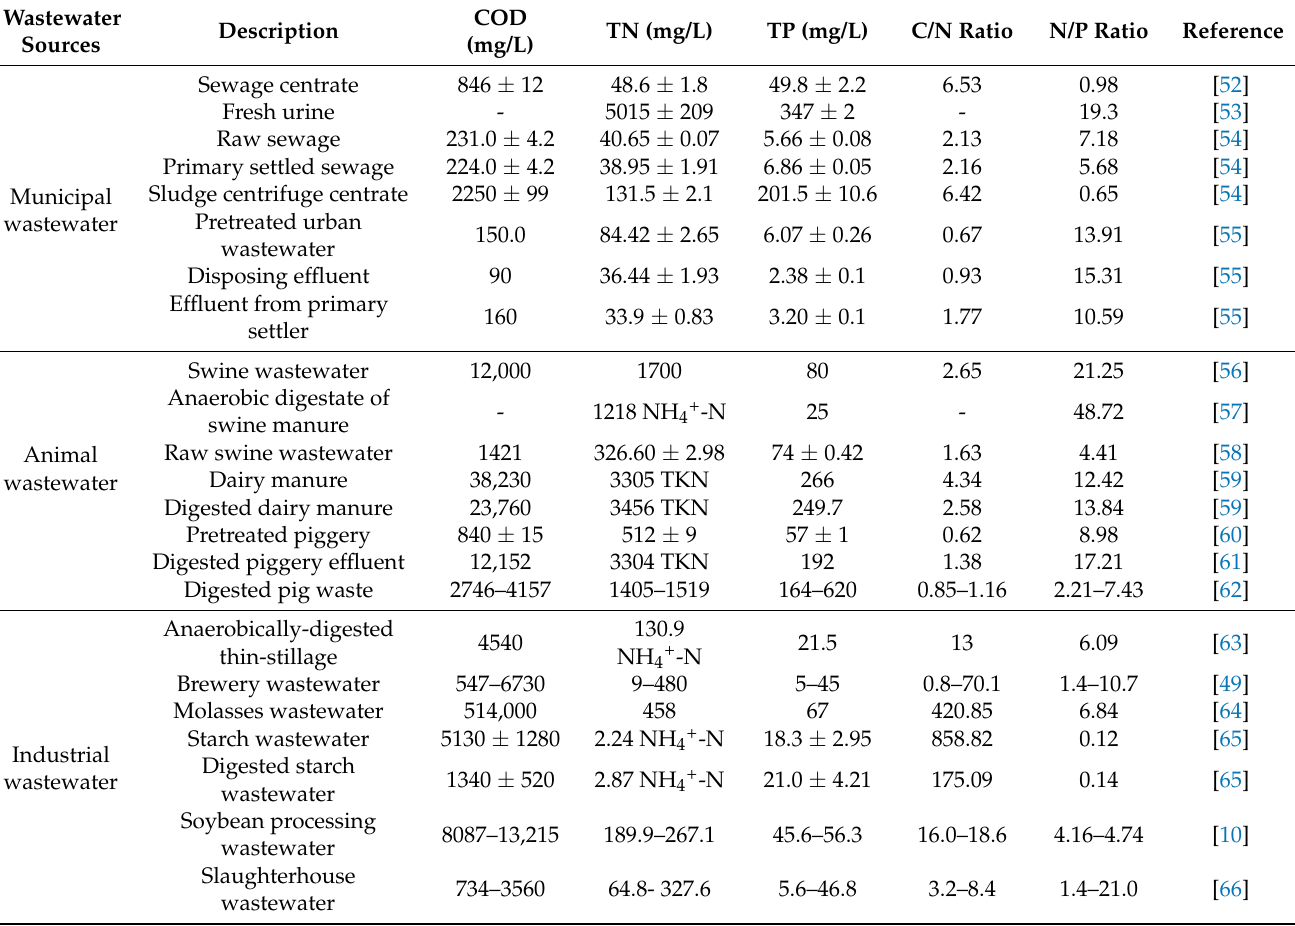
Table 2. Different waste streams with various C/N and N/P